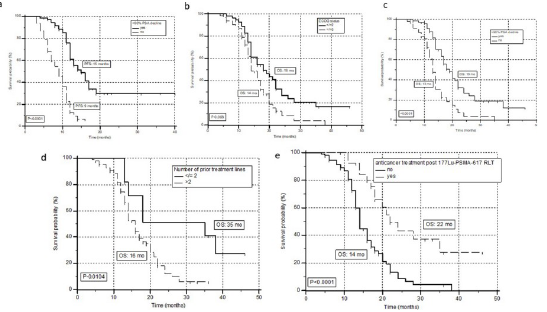
Fig 3. Kaplan-Meier plots of prognostic factors associated with PFS and OS. a. Kaplan-Meier plots of progression- free survival comparing the patient cohort wit > 50% PSA decline vs. no decline. b-e. Kaplan-Meier curves of factors such as ECOG status (cut-off: 2), > 50% PSA decline, number of prior systemic treatment lines of treatment (cut-off: 2), and further anti-cancer treatment post 177 Lu-PSMA-617 RLT associated with the overall survival.